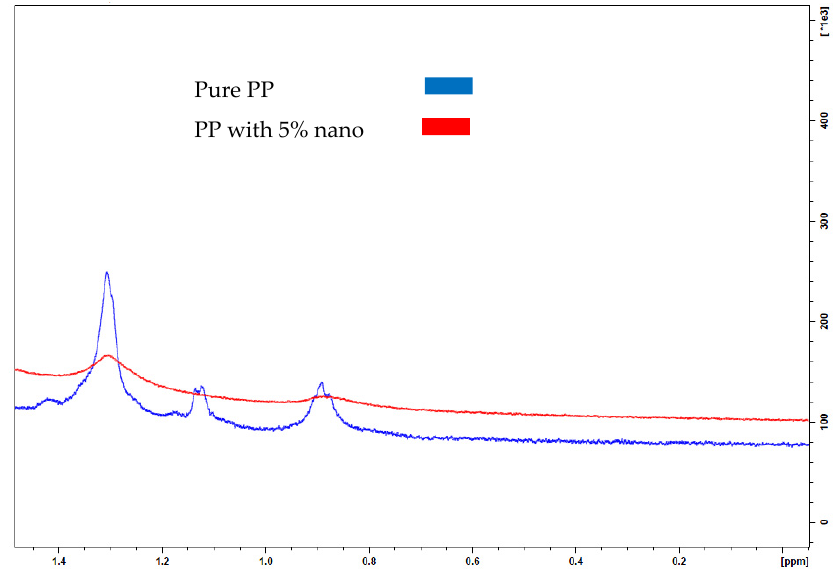
Figure 2. NMR analysis for PP pure and PP nanocomposites with nano-CaCO 3 2% wt.